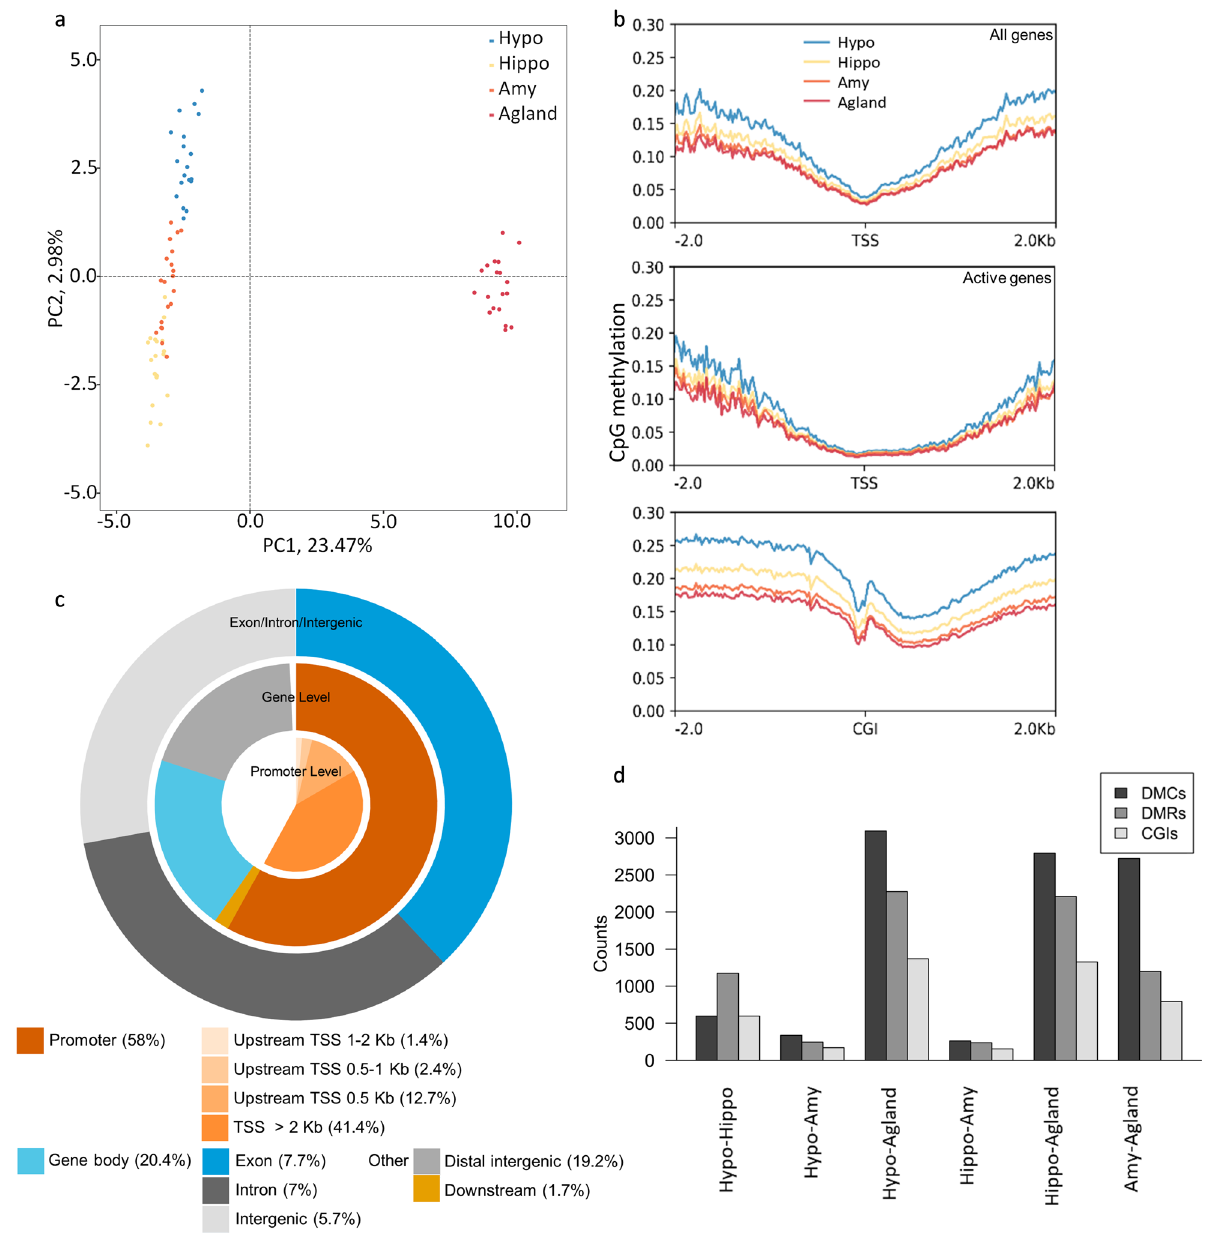
Figure 1. Differentially methylated CpG sites in four tissues: the hypothalamus (Hypo), hippocampus (Hippo), amygdala (Amy), and adrenal gland (Agland) from German Landrace pigs. ( a ) Principal component analysis. ( b ) Profile plot 61 depicting the methylation rate centered to: TSS of all genes in Sscrofa11.1 (top), TSS of genes with expression values in the mRNA profiling expression data from the same individuals (middle), and to annotated CGIs (bottom). Y-axis shows methylation level as methylation rate per CpG. ( c ) Feature annotation for 60,090 common meCpGs. The percentages for the promoter and gene body are split into sub-features. ( d ) Counts of significantly DMCs and DMRs, and annotated CGIs overlapping with the DMRs detected